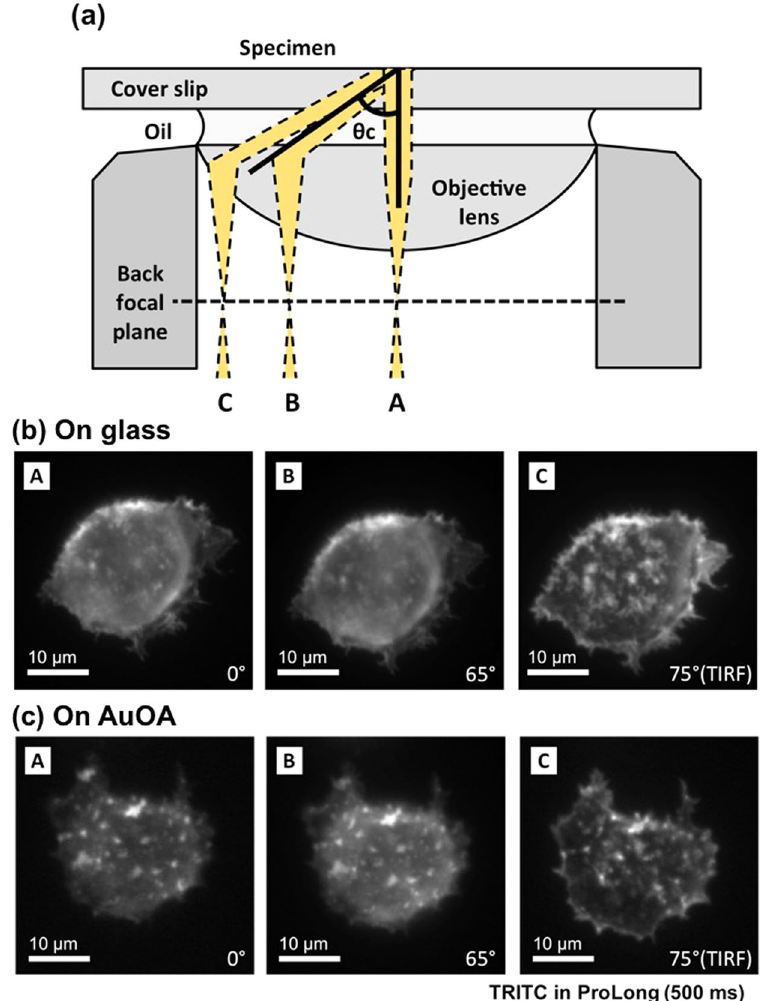
Figure 4. Angular-dependent fluorescence images on glass and on the AuOA sheet. ( a ) Schematic drawing of various incident angles under a TIRF microscope for A: 0°, B: 65°, and C: 75° when the critical angle of TIR ( θ c ) was 74.4°. ( b ) Fluorescence images of the TRITC-labeled actin filaments in the RBL-2H3 cells in aqueous media. The images were taken with a laser 561 nm in wavelength (5 mW), and the exposure time was 500 msec. The incubation time for the cell adhesion was 30 min, when the cells formed round shapes indicating an early stage of adhesion (see Supplementary Fig.